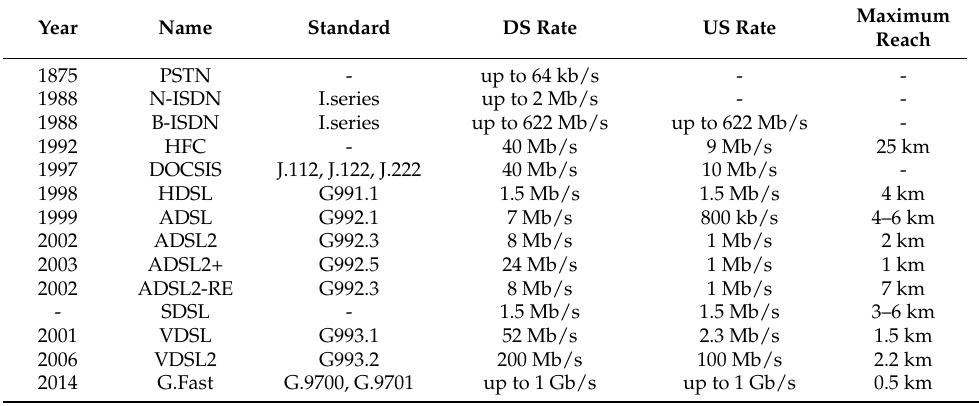
Table 4. Details of various fiber-based access standards. Year